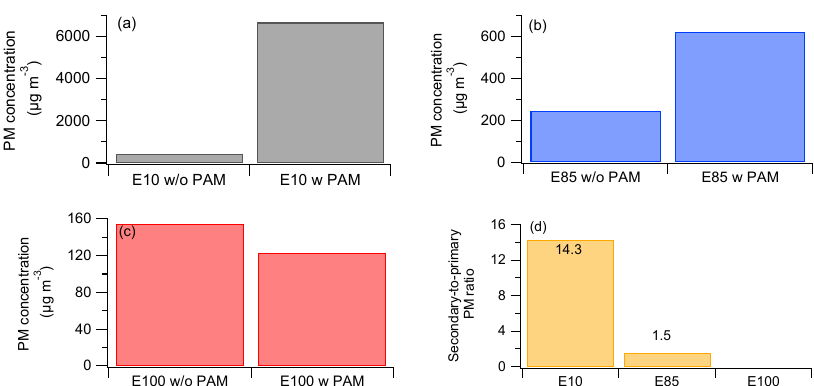
Figure 6. The primary submicron PM concentrations in the exhaust emissions measured without the PAM chamber and the submicron PM concentrations measured with the PAM chamber for E10 (a) , E85 (b) and E100 (c) . The secondary-to-primary PM ratio for the submicron PM mass in the exhaust calculated from the SP-AMS measurements (d) . The concentration of the secondary particulate emissions was calculated by subtracting the concentration of the primary PM from the PM measured after the PAM